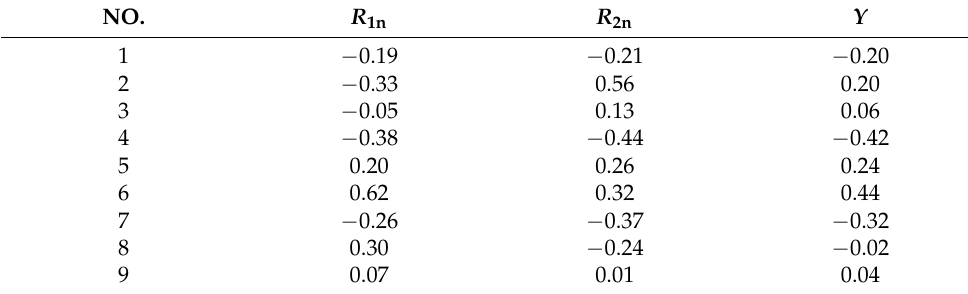
Table 4. Value of comprehensive evaluation.